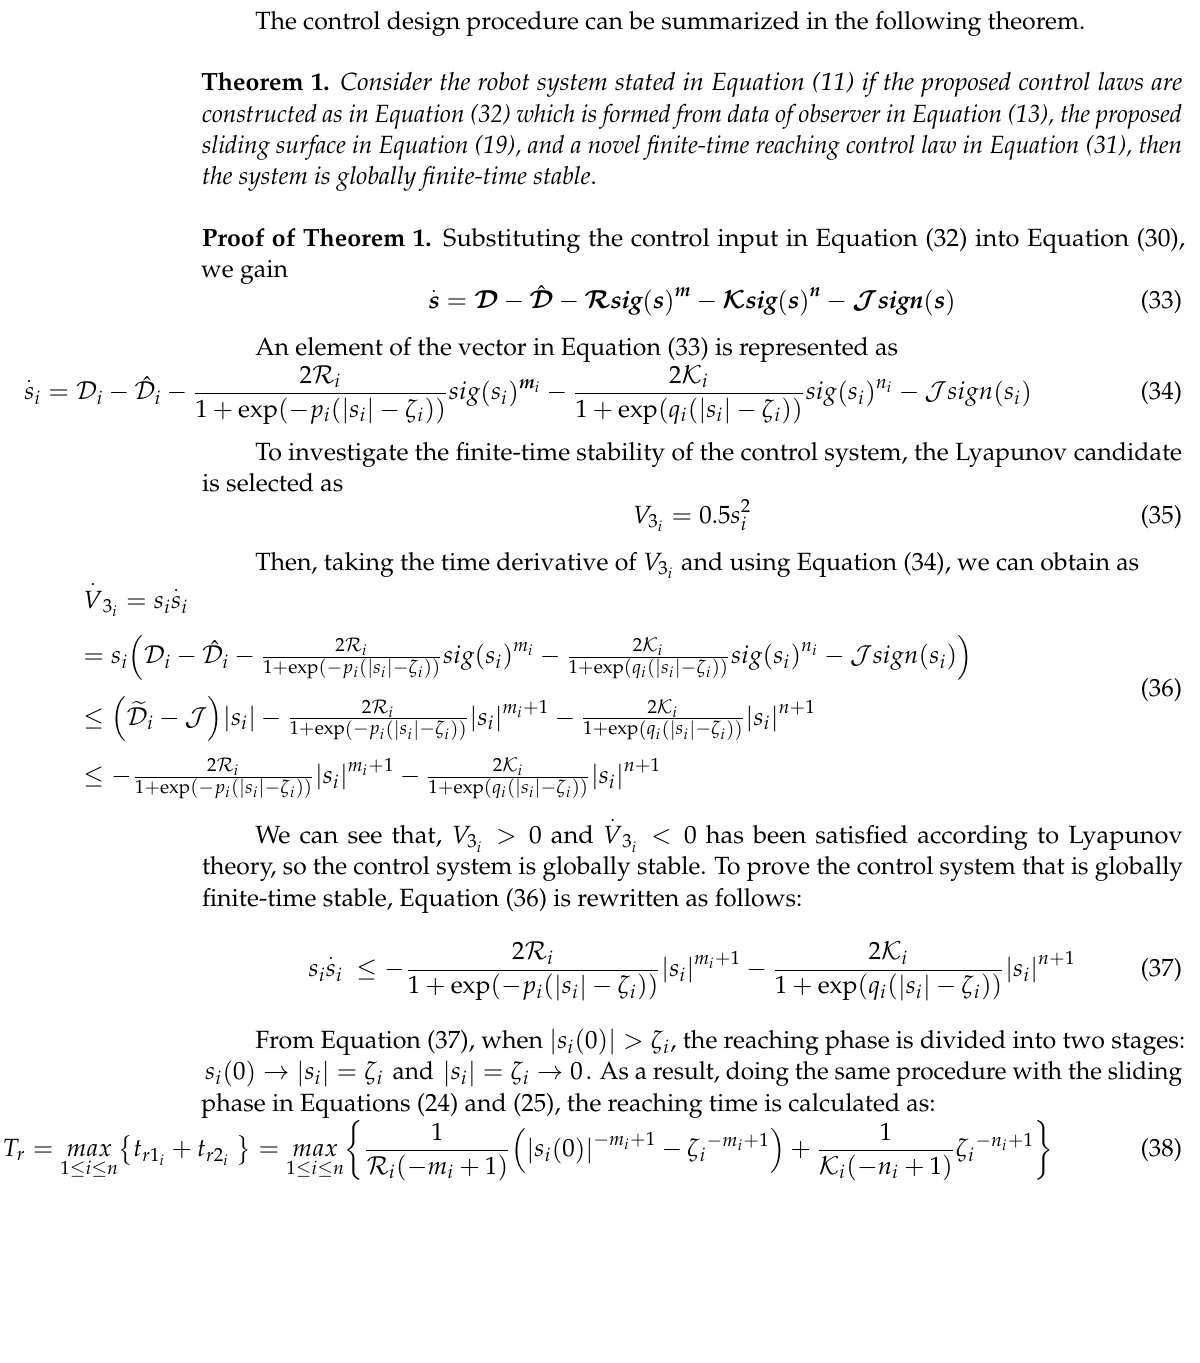
Figure 1. The block diagram of the proposed control